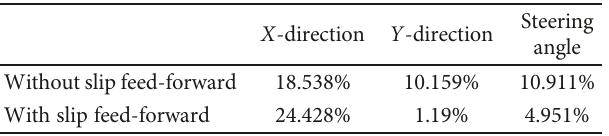
Table 1: The comparison of the accumulated absolute error ratios while tracking a circular trajectory. X -direction Y -direction Steering angle Without slip